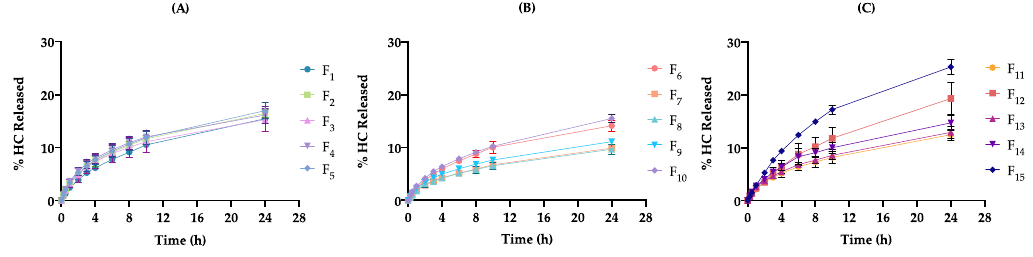
Figure 4. E ff ect of independent variables on cream release profile: ( A ) F 1 –F 5 , ( B ), F 6 –F 10 and ( C ) F 11 –F 15 Figure 4. Effect of independent variables on cream release profile: (A) F 1 –F 5 , (B), F 6 –F 10 and (C) F 11 – F 15 .